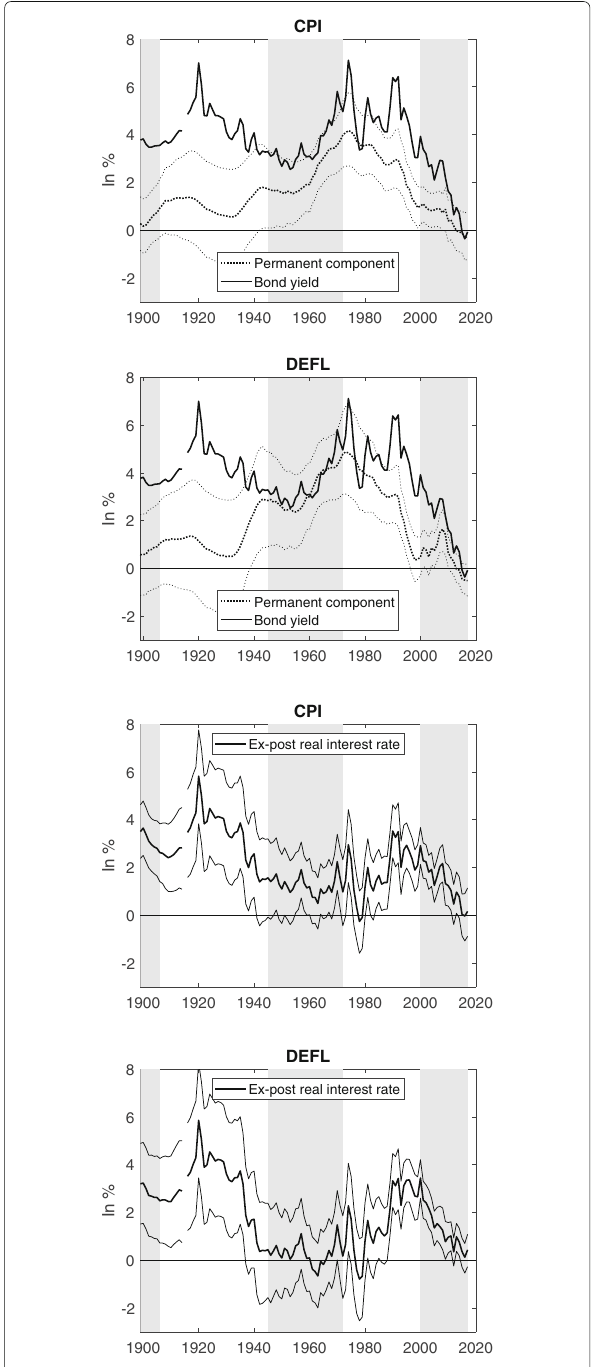
Fig. 4 Bond yields and real interest rates. The solid lines in the first and second panels show a spliced measure of government bond yields (maturity between 5 and 10 years). The dashed lines show the estimated permanent component (mean, 5th percentile, 95th percentile). The third and fourth panels show the implied ex-post real interest rate (mean, 5th percentile, 95th percentile). The shaded areas highlight changes in monetary